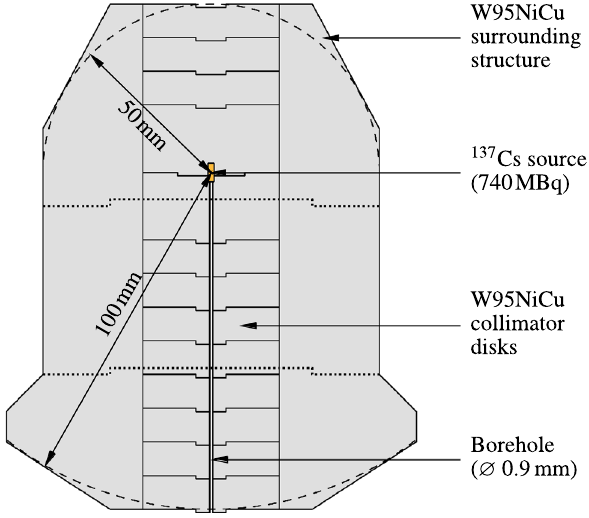
Fig. 3 Schematic cross section of the rotationally symmetric 137 Cs source collimator a narrow vertical beam, the source is embedded in a collima-